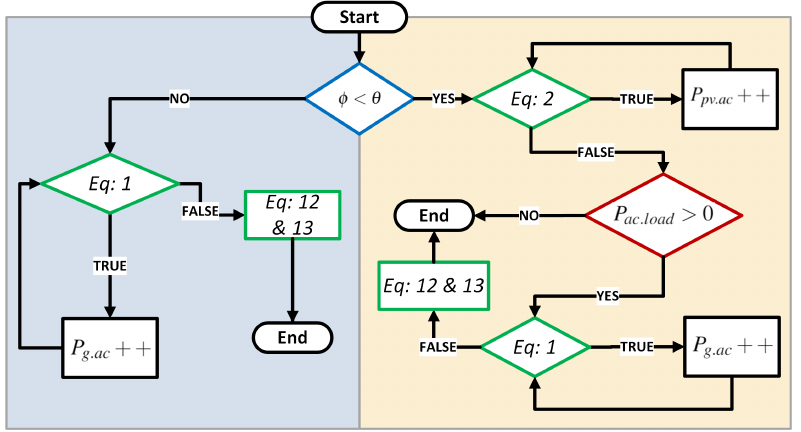
Figure 8. Case III flow